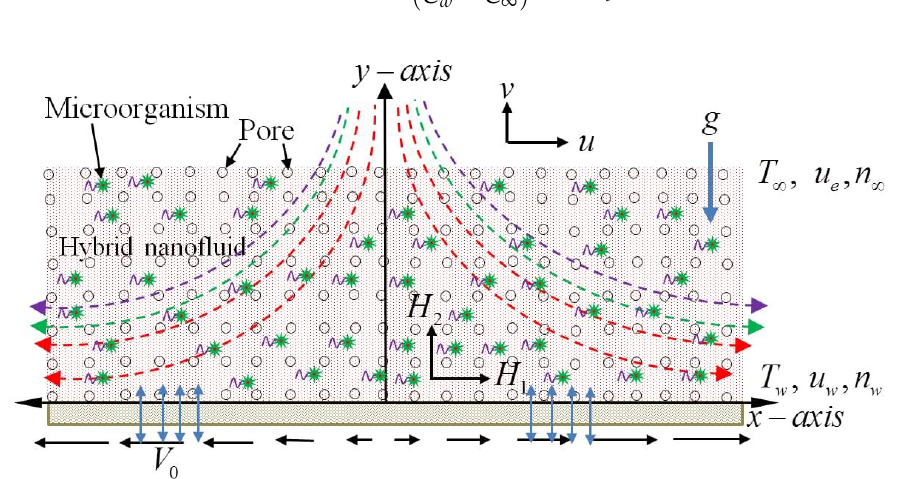
Figure 1. Two-dimensional problem and coordinate system of the Schematic diagram. Table 1. Nanoparticles and primary base fluid have the following thermophysical properties [8]. Thermophysical Properties Fluid Phase